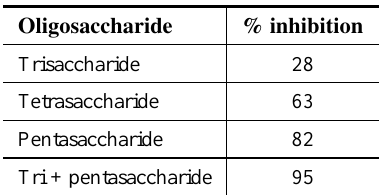
Maximum inhibition (%) of S. schenckii peptidorhamnomannan immunoprecipi- tation with its derived O-linked oligosac- charides (at 1 µ mol) a